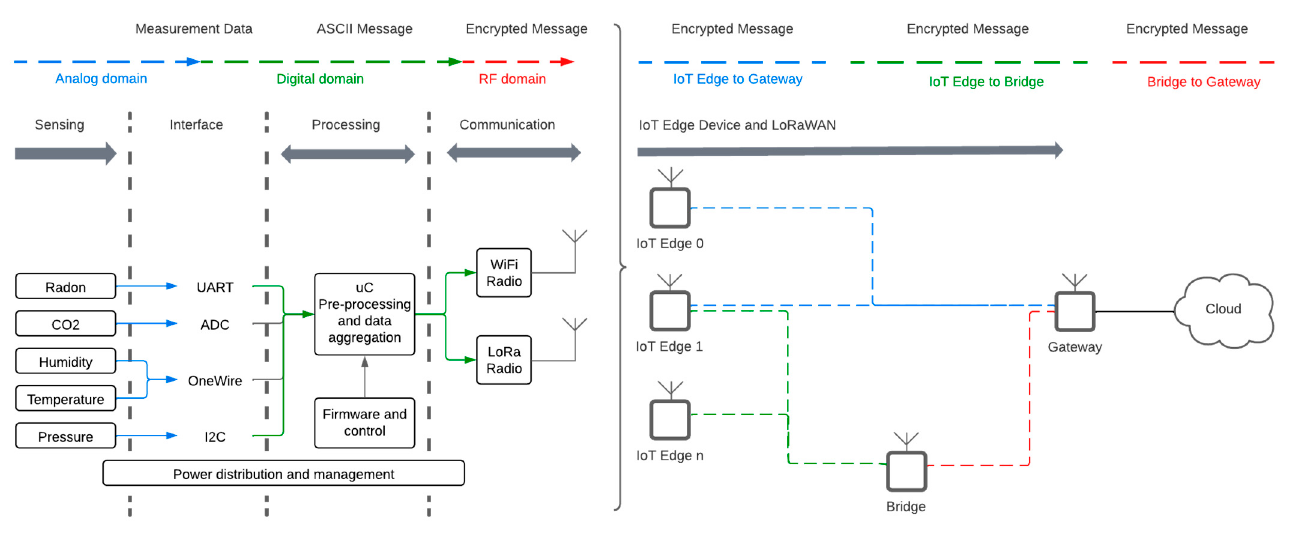
Figure 1. RnProbe IoT edge building blocks and LoRaWAN operation modes (adapted from [30]